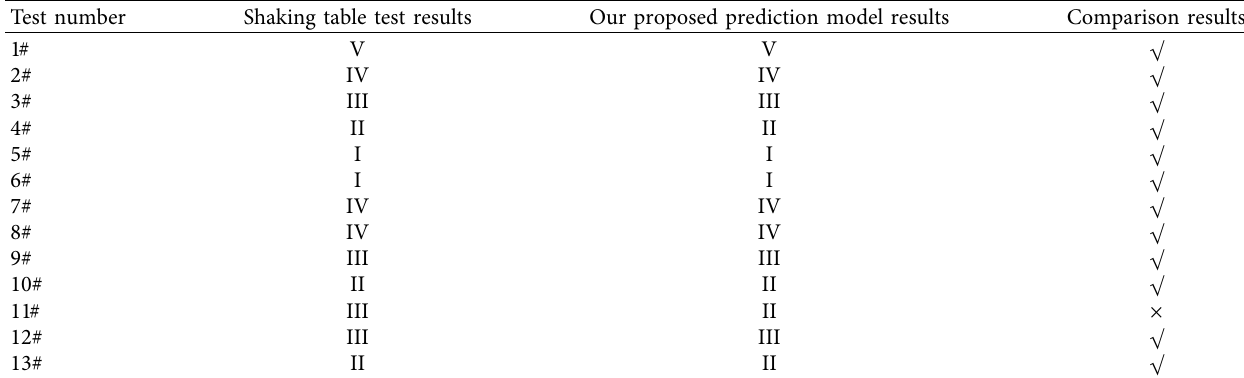
Table 11: Slope stability prediction results of different methods. Shaking table test results Our proposed prediction model results Comparison